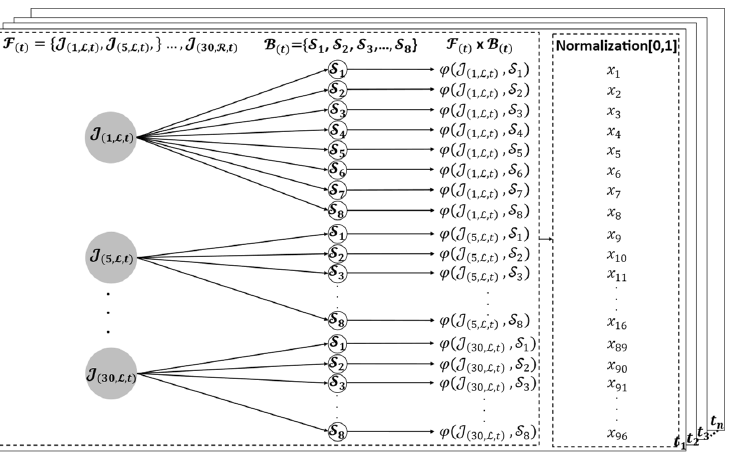
Figure 3. Distance ‐ based features based on Cartesian products. Figure 3. Distance-based features based on Cartesian products.